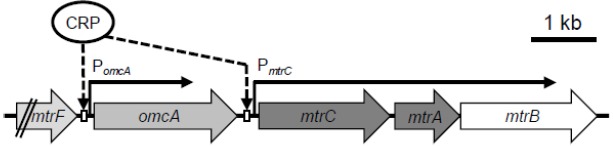
Organization and proposed transcriptional mechanisms of the mtr genes. Two CRP-binding sites adjacent to promoters of omcA (PomcA) and mtrC (PmtrC) are shown (Kasai et al., 2015).